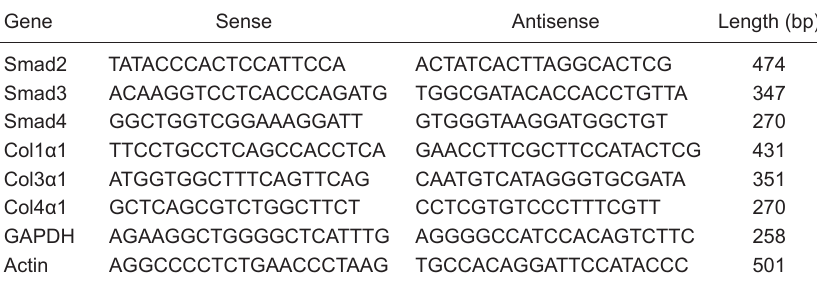
Table 1. PCR primer sequences of Smads, collagens (Col), GAPDH, and Actin.